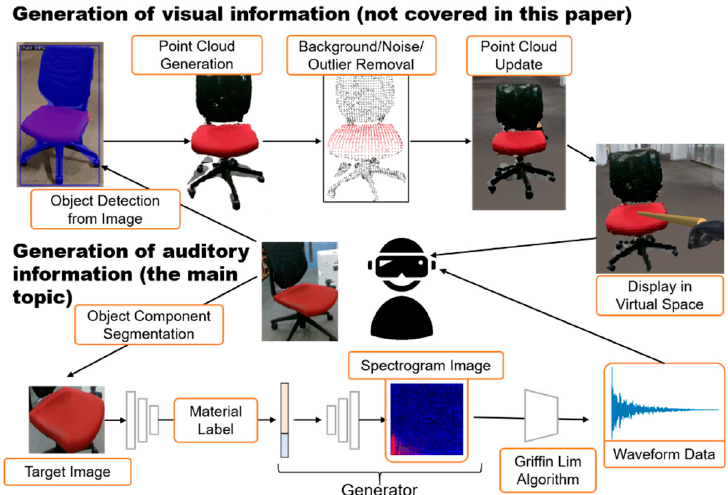
Figure 4. System configuration for audiovisual interaction with movable objects.